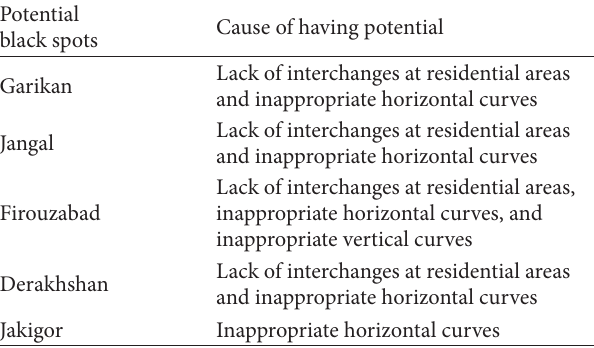
Table 5: Section 5: Pashaamag Mortaan-Jakigor.